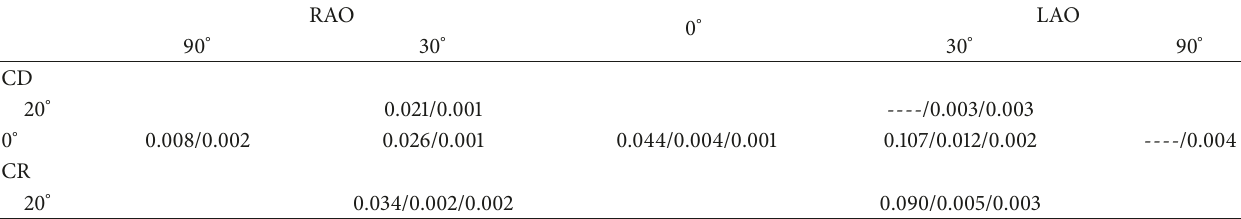
Table 4: Dose from scatter radiation normalized to 𝑃 KA ( 𝜇 Gy/ 𝜇 Gy ∗ m 2 ) for radiology (in each cell dose without the use of shielding, with shielding placed close to the patient, and with shielding placed close to the physician. When there are only two values in the cell, the measurements with shielding placed close to the patient and with shielding placed close to the physician were the same). RAO 0 ∘